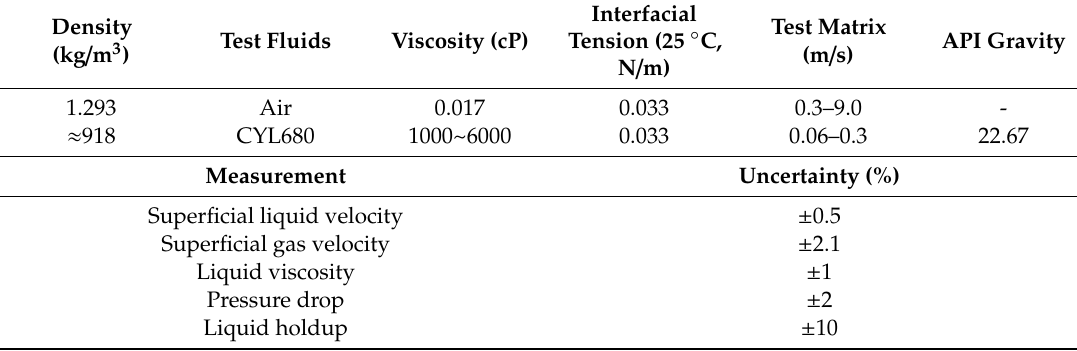
Table 2. Test matrix for experimental run and measurement